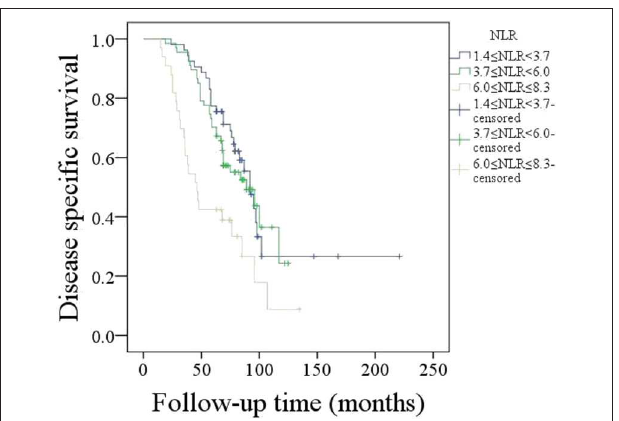
FIGURE 2 | Disease-specific survival in patients with different neutrophil-to-lymphocyte ratios (NLRs) ( p = 0.001).